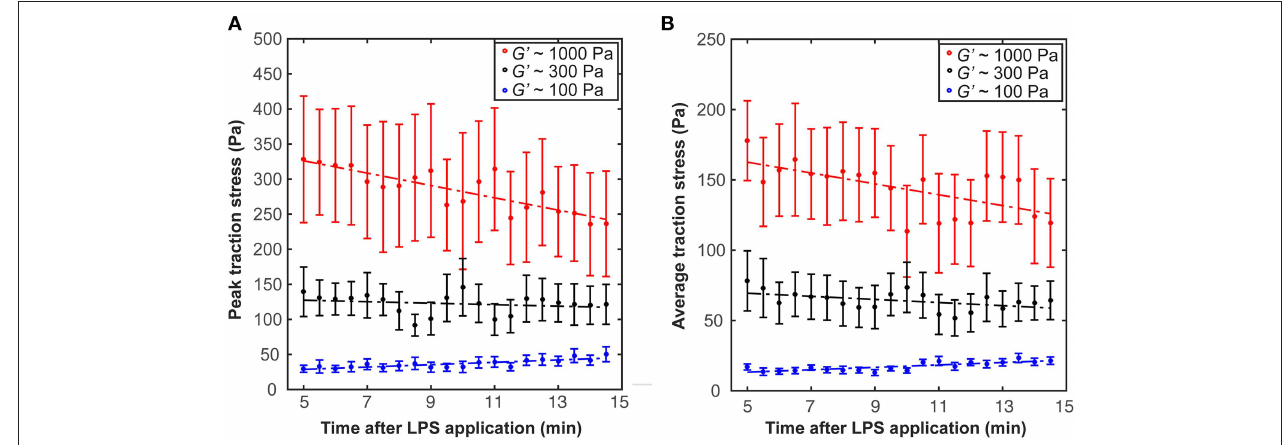
FIGURE 5 | Microglia activation through LPS changes traction stresses. After 5min incubation in LPS, (A) peak traction stresses and (B) average traction stresses decreased on stiffer substrates ( G ′ ∼ 300 or 1000 Pa) but slightly increased on soft gels of G ′ ∼ 100 Pa (shown is the mean ± SEM).